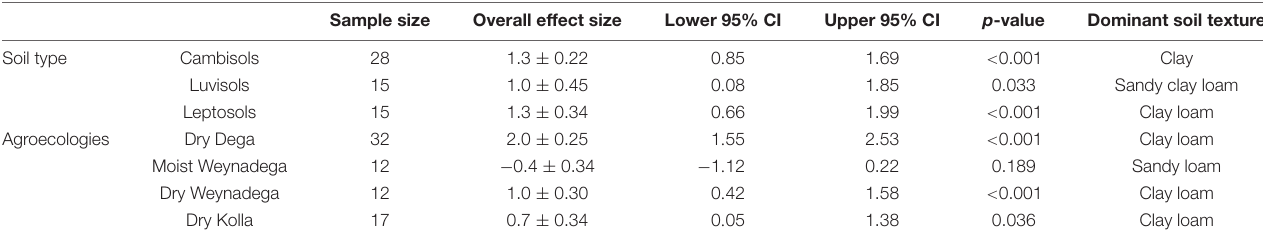
TABLE 3 | Changes in soil organic carbon after establishment of exclosures on communal grazing lands.